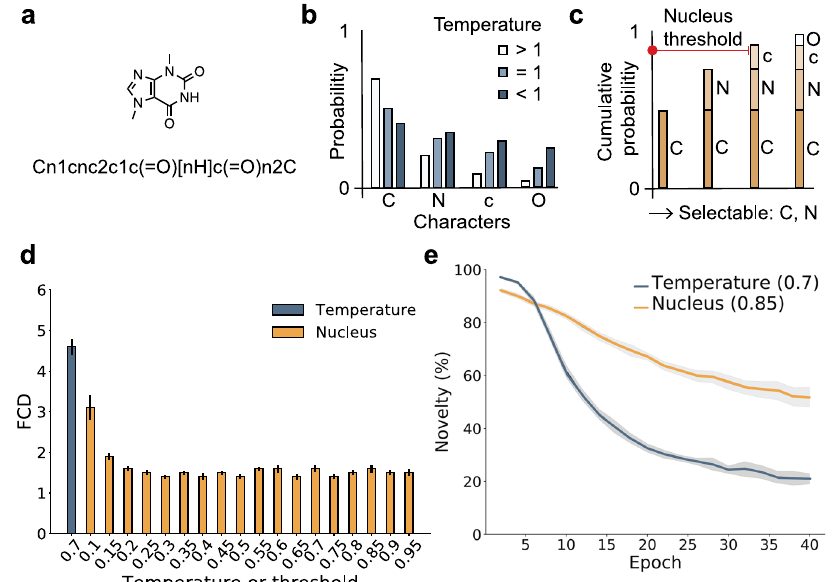
Fig. 1 | De novo molecular generation with the CLM. a SMILES string repre- sentation of a molecule. b Example of the effect of the temperature parameter on the probability distribution learnt by the CLM. c Example of the effect of the nucleus sampling threshold. Only the characters N and C can be sampled here. d Fréchet ChemNet Distance(FCD)comparison between temperatureand nucleus sampling after the pretraining (reported as the mean with standard deviation over 10 repeats with 5000moleculessampled per repeat). e Comparisonofthe novelty